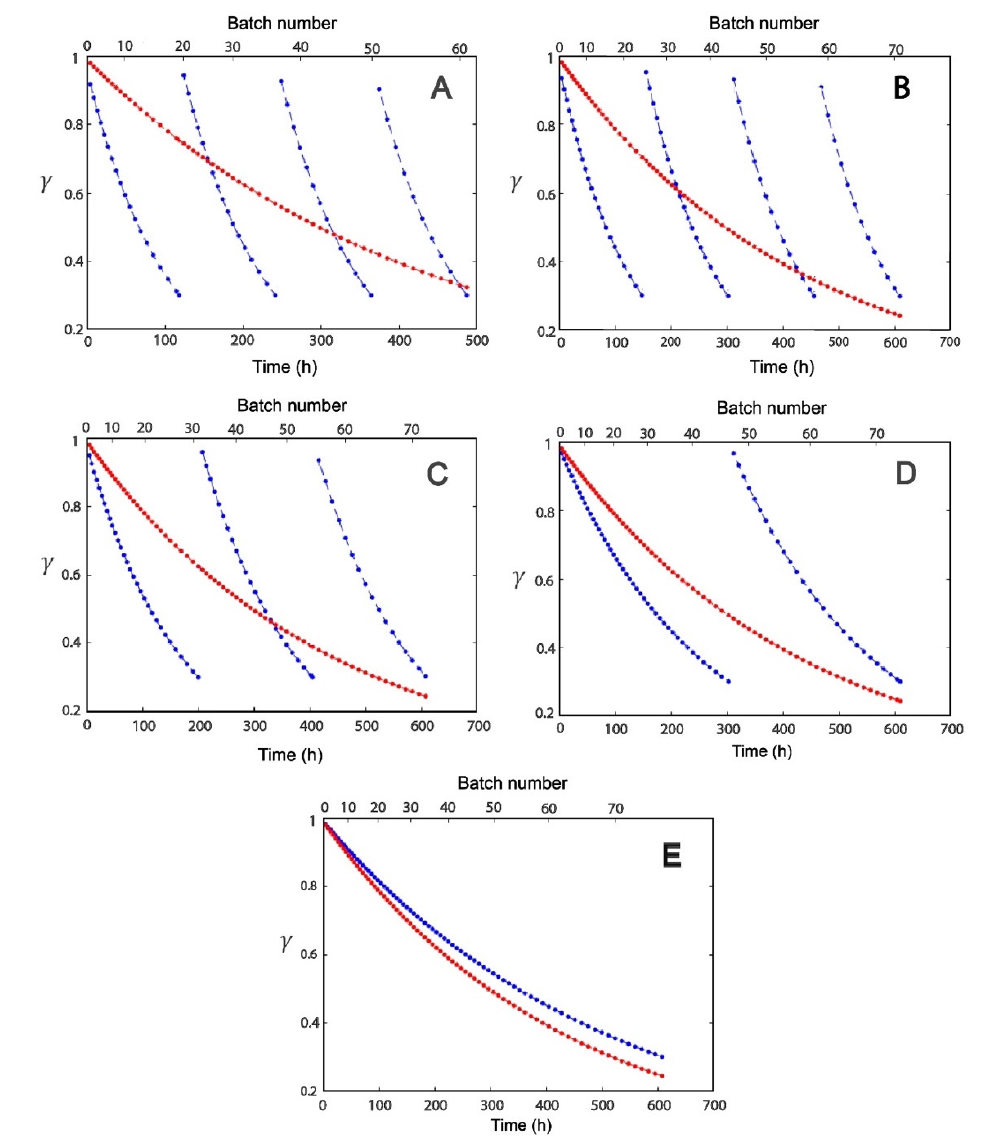
Figure 4. Operational stability of β -gal and GI in terms of reaction time and number of sequential batches during the one-pot production of lactofructose syrup in sequential batch operation. Simulations were performed considering 40 °C, pH 7, 10% ( w/w ) of initial lactose concentration and GI/ β -gal activity ratio of 0.46 (IU GI /IU β -gal ). ( A ) η = 0; ( B ) η = 0.2; ( C ) η = 0.4; ( D ) η = 0.6; ( E ) η = 0.8. Operational stability of β -gal: blue lines; stability of GI: red lines.